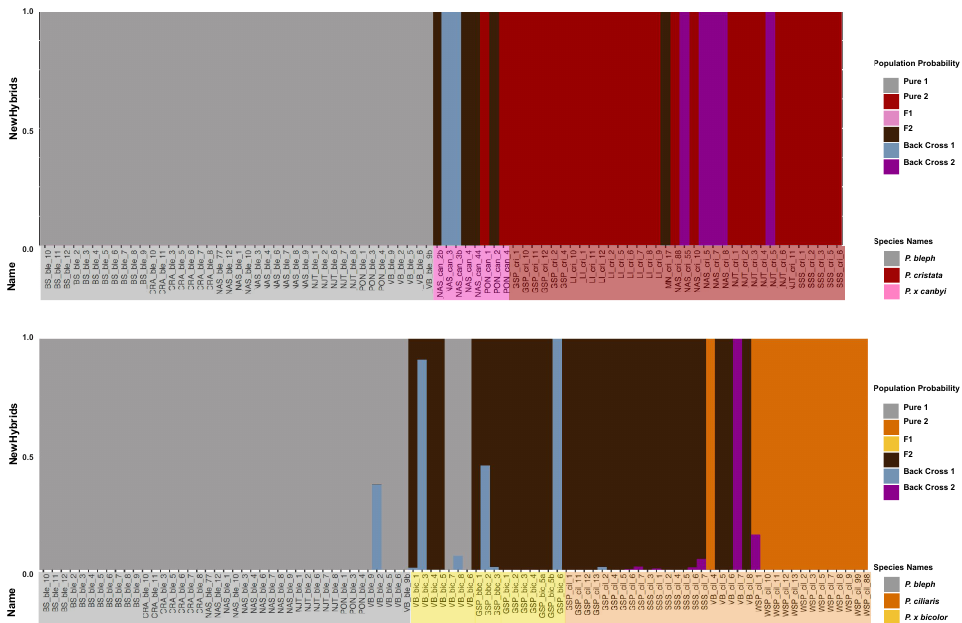
Figure 5. Genotype assignment of the Platanthera hybrid complex. The bars are a cumulative probability for the different population types: pure parent 1 (gray), pure parent 2 (red for the top graph and orange for the bottom graph), F1 hybrid (pink for the top graph and yellow for the bottom), F2 hybrid (brown), backcross with parent 1 (blue), and backcross with parent 2 (purple). Below each bar is the sample identification with a color reflective of species. The allopatric sites with one parent species are BS, CRA, LI, and